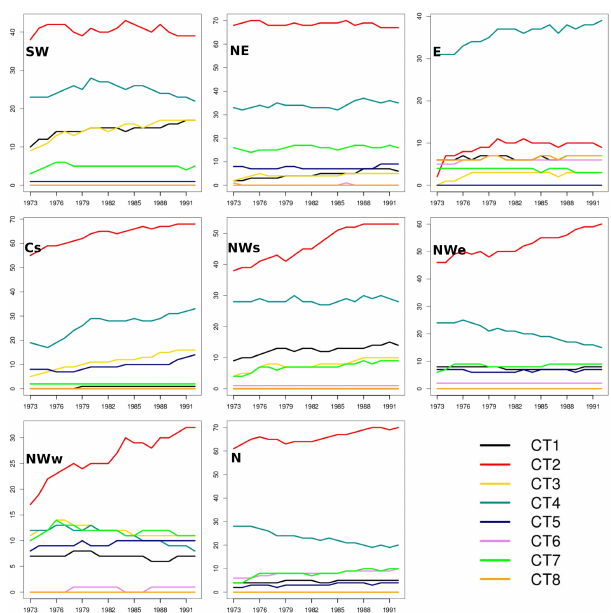
Figure 7. Within-type variations. The lines represent the moving average (31 years) of the efficiencies for the CTs composing the best CT classification (colour) for each region (panel) after the allocation